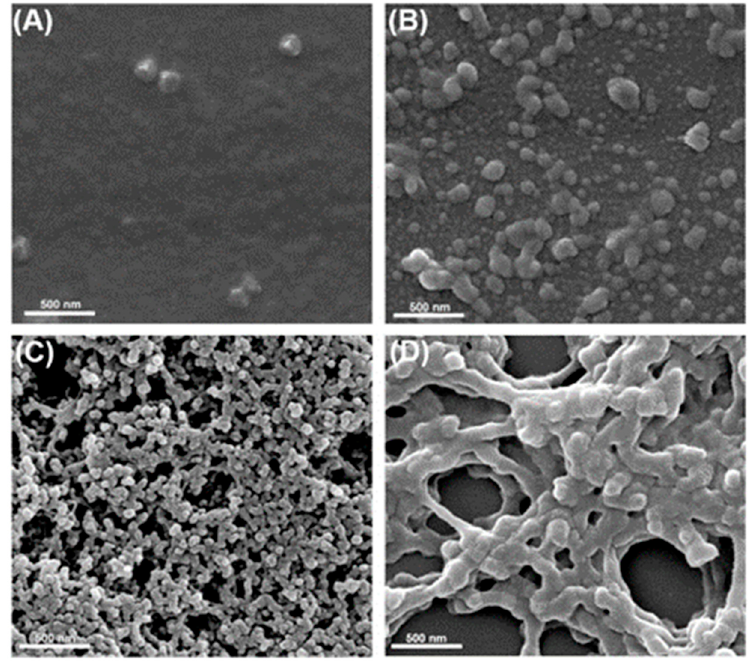
Figure 2. SEM images of SPEN before ( A ) and after crosslinking with Al 3+ at different concentrations: ( B ) 0.05M, ( C ) 0.10 M and ( D ) 0.15 M in aqueous